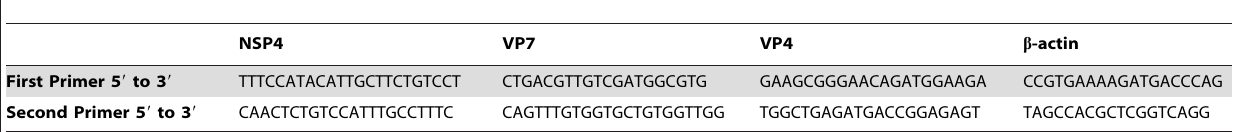
Table 3. Primers for mRNA of NSP4, VP7, VP4 and b